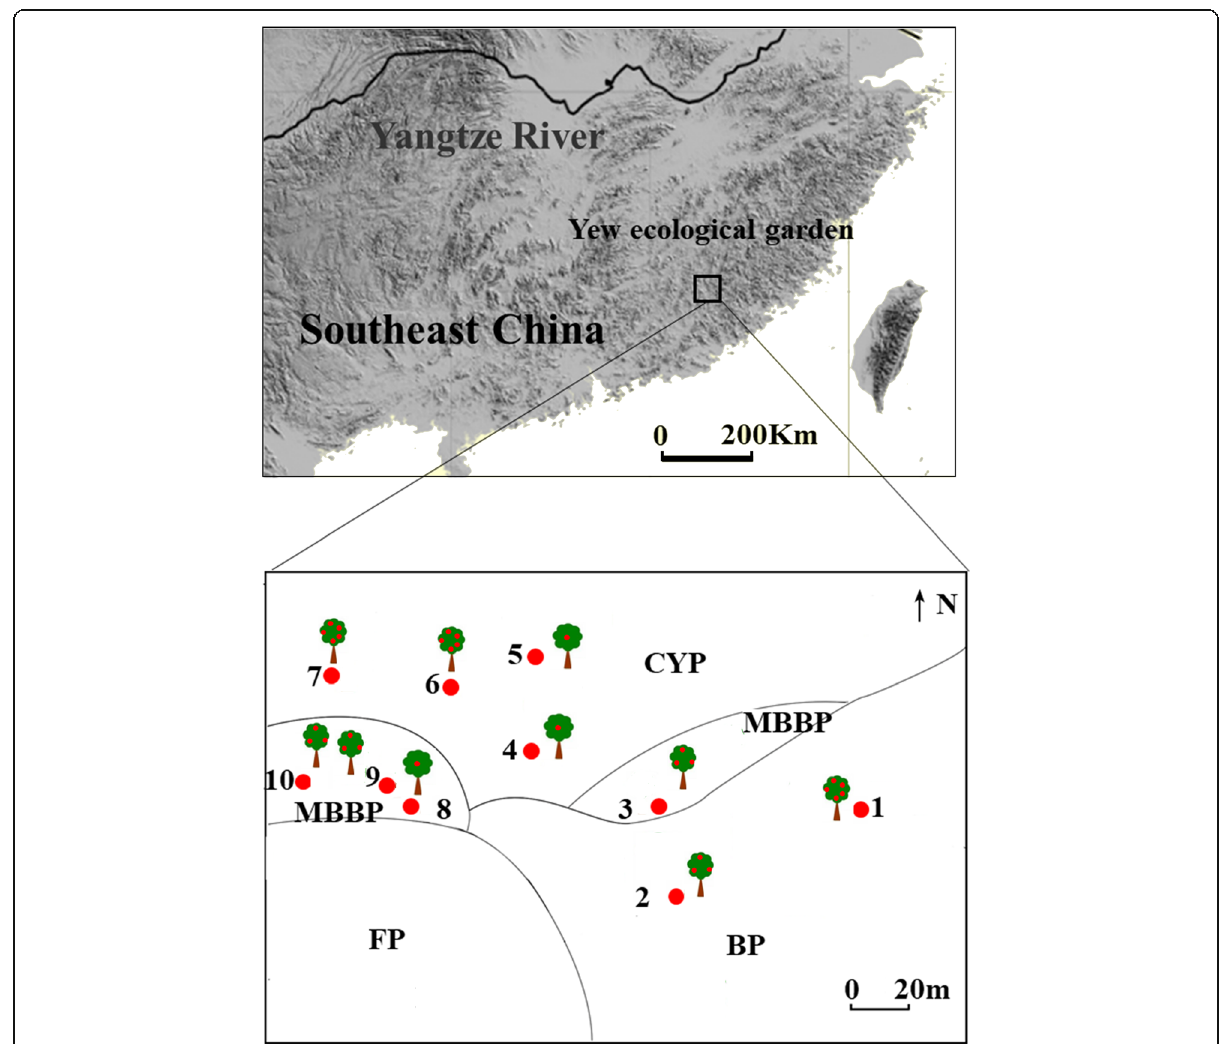
Fig. 1 Study site and distribution of mother trees in different patches in yew ecological garden, Fujian Province, southeast China. CYP: evergreen broad-leaved forest patch; MBBP: mixed bamboo and broad-leaved patch; BP: bamboo patch; FP: farmland patch. Red dots in the trees represent the fruit amount, 1 dot represent seeds < 15,000; 3 dots represent 15,000 < seeds < 20,000; 5 dots represent seeds >